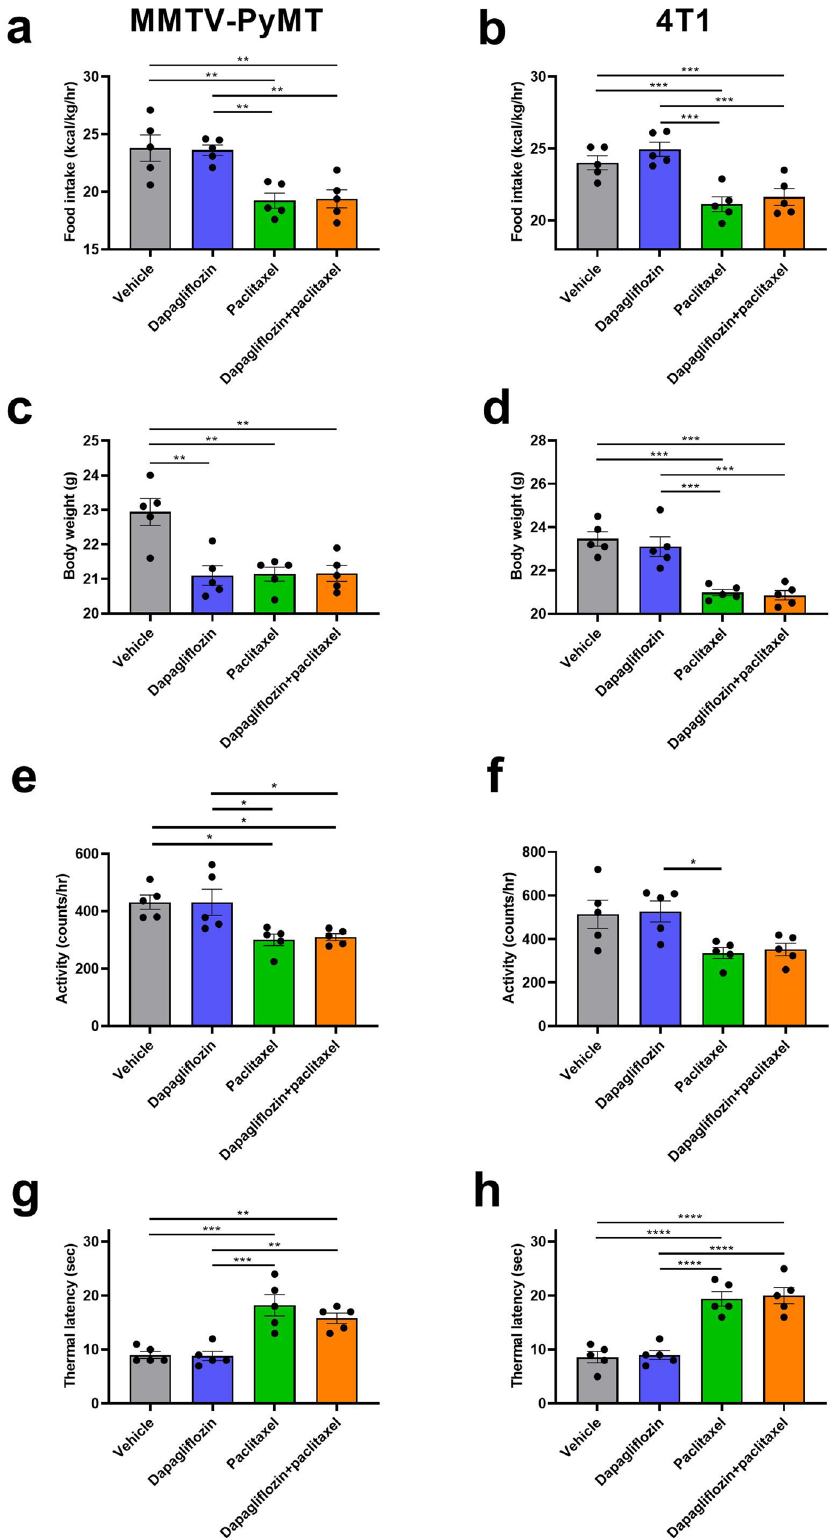
Fig. 5 Dapagli fl ozin has no adverse effects to cause fatigue, anorexia, weight loss, or neuropathy in MMTV-PyMT or 4T1 tumor-bearing mice. a , b Ad lib food intake, measured in metabolic cages. All metabolic cage studies in this fi gure were performed after 3 weeks of chemotherapy or vehicle treatment in MMTV-PyMT and 4T1 tumor-bearing mice, respectively. c , d Body weight, measured after 4 weeks of treatment. e , f Spontaneous activity. g , h Thermal latency during week 3 of chemotherapy or vehicle treatment. In all panels, * P < 0.05, ** P < 0.01, *** P < 0.001 by ANOVA with Tukey ’ s multiple comparisons test. Groups of n = 5 were